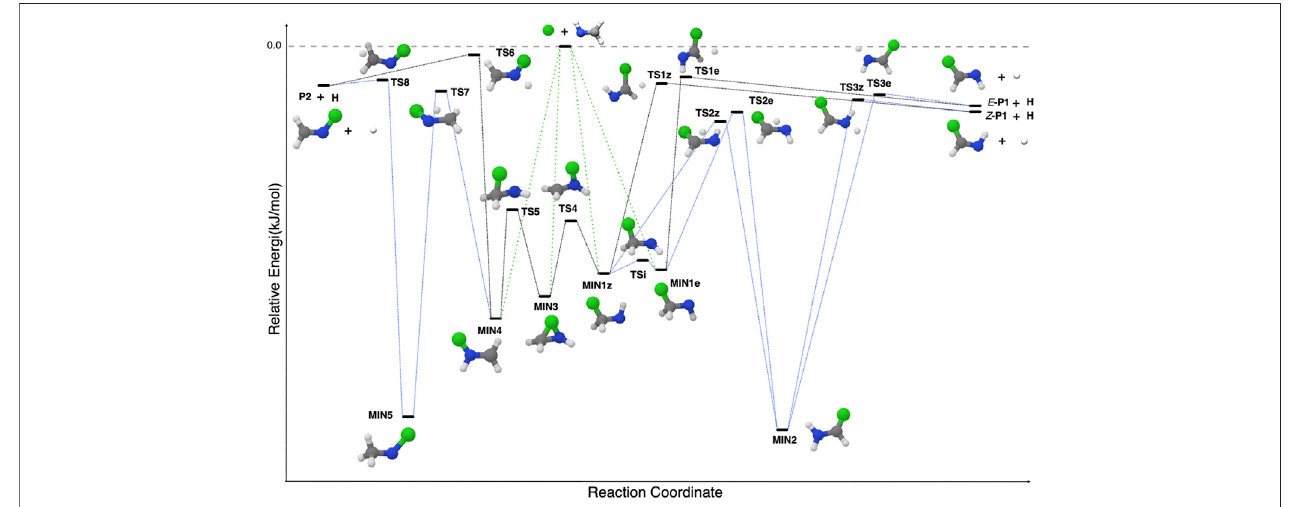
FIGURE 6 | The general mechanism for the X + CH 2 NH reaction, where X (the ‘ green ball ’ in the fi gure) is a generic small radical.